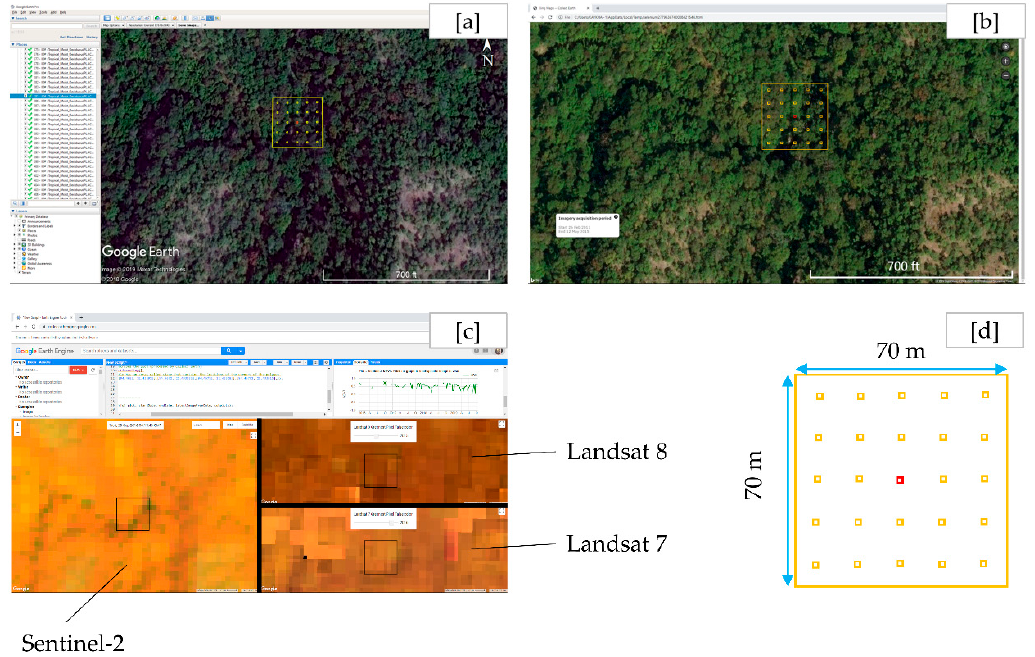
Figure 2. Geo-synchronized view of each sample using Collect Earth Software: ( a ) Google Earth image, ( b ) Bing Map image, ( c ) Google Earth Engine showing normalized di ff erence vegetation index (NDVI) values and di ff erent satellite images, such as Sentinel-2, Landsat 7, Landsat 8, ( d ) schematic of a 0.49 ha plot with 25 points. The red point in the center of the plot represents the original sample described in Section 2.3.1.